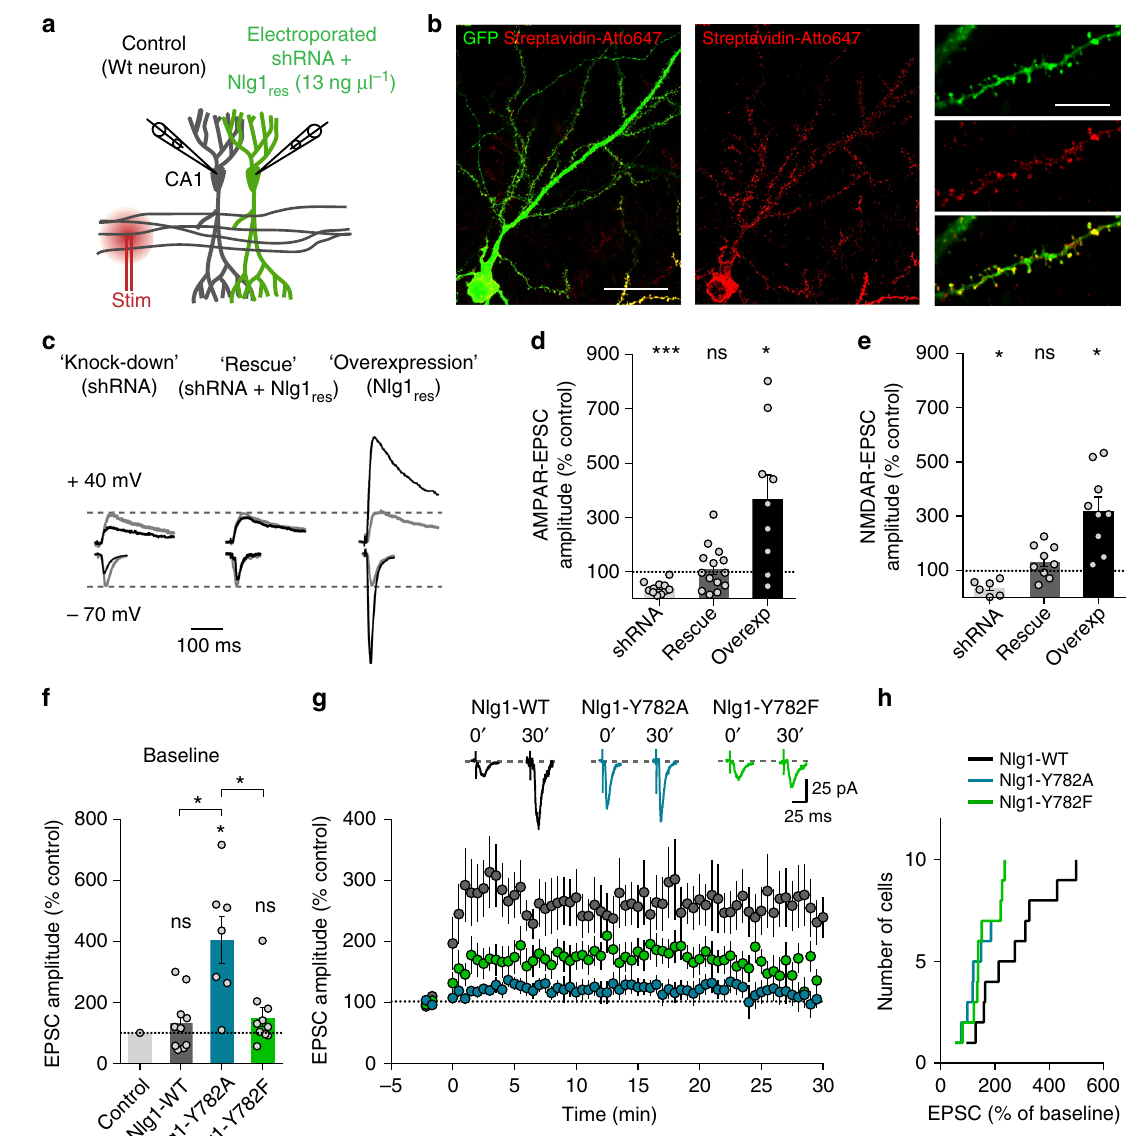
Fig. 6 Nlg1 replacement by Nlg1 point mutants and LTP experiments. a – e Nlg1 replacement strategy. a CA1 neurons of organotypic hippocampal slices from wild-type mice were single-cell electroporated at DIV 3 – 5 with either Nlg1 shRNA alone (knockdown), Nlg1 shRNA + resistant Nlg1-WT (rescue), or with resistant Nlg1-WT alone (overexpression). b Representative confocal images of a CA1 neuron co-expressing the GFP reporter from the shRNA (green) and biotinylated AP-Nlg1 stained with streptavidin-Atto647 (red). Scale bars, 40 µ m (left panels) and 10 µ m (right panels). c Representative traces of evoked AMPAR and NMDAR-mediated EPSCs recorded at − 70 mV and + 40 mV, respectively, in electroporated (black) and control (gray) neurons. d , e Average AMPAR- and NMDAR-mediated EPSCs, respectively, in the three conditions (dot plots corresponds to different pairs, from 3 independent experiments). f Average basal AMPAR-mediated EPSCs in CA1 cells co-expressing shRNA to Nlg1 plus Nlg1-WT, -Y782A, or -Y782F rescue constructs (dot plots corresponds to different pairs, from 5 independent experiments). g Average AMPAR-mediated EPSCs for the three conditions, upon LTP induction at time 0. Sample traces are shown at time 0 and 30 min after LTP induction. h Cumulative distribution of the long-term plateau of AMPAR-mediated EPSC in the three conditions, expressed as a percentage of the baseline level. Data in graphs d – g represent mean ± SEM and were compared to the control condition (unelectroporated) by Wilcoxon matched-pairs signed rank test (* P < 0.05, *** P < 0.001, ns: not signi fi cant compared to